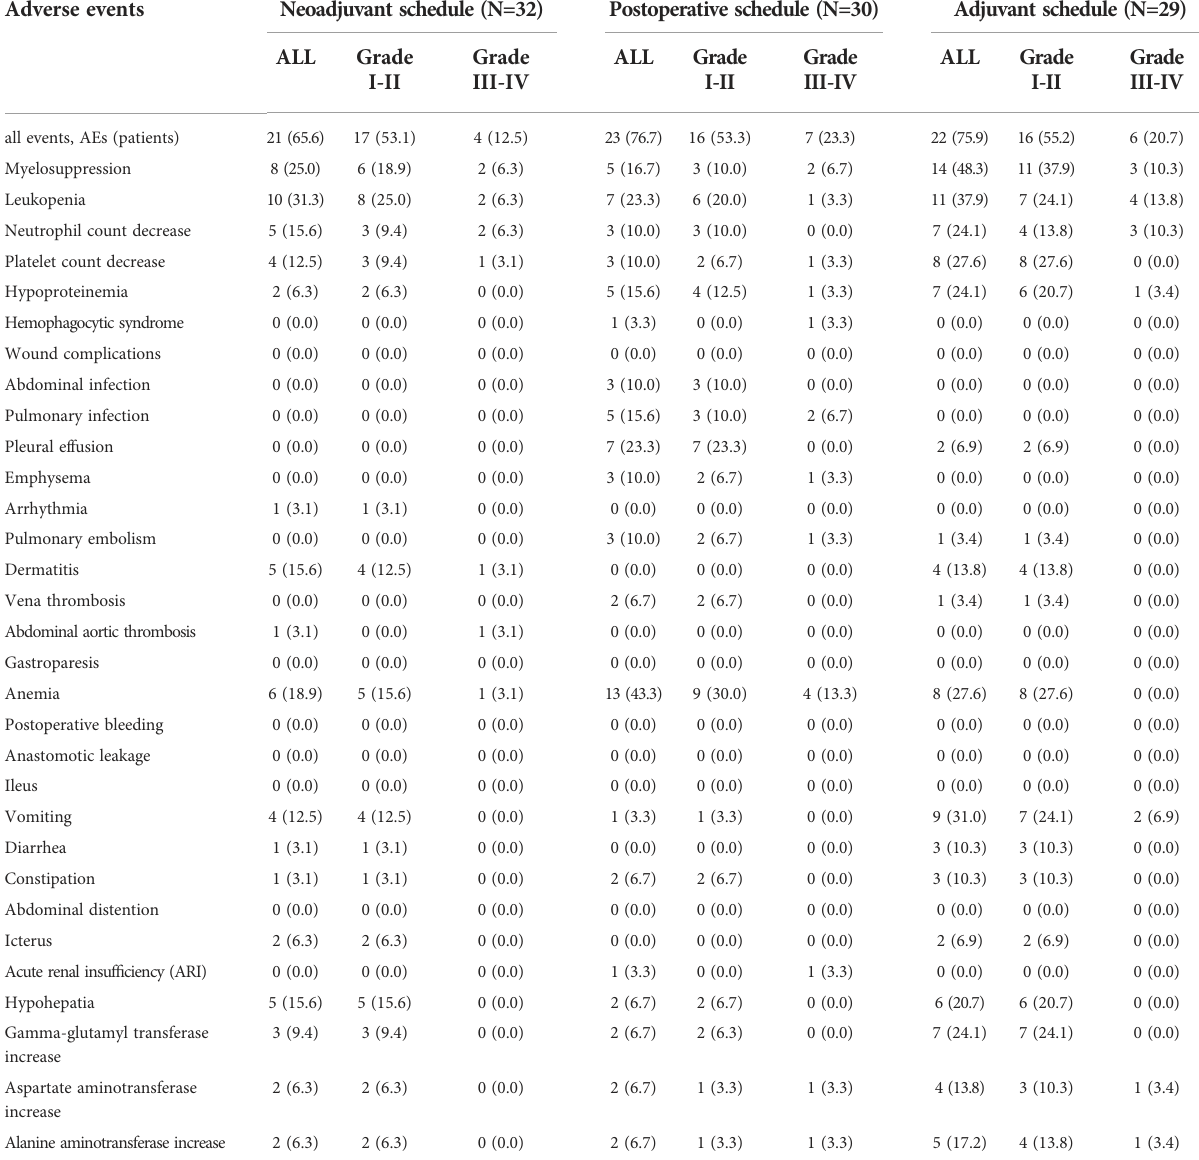
TABLE 2 Treatment-related adverse events for all patients (N=32). Adverse